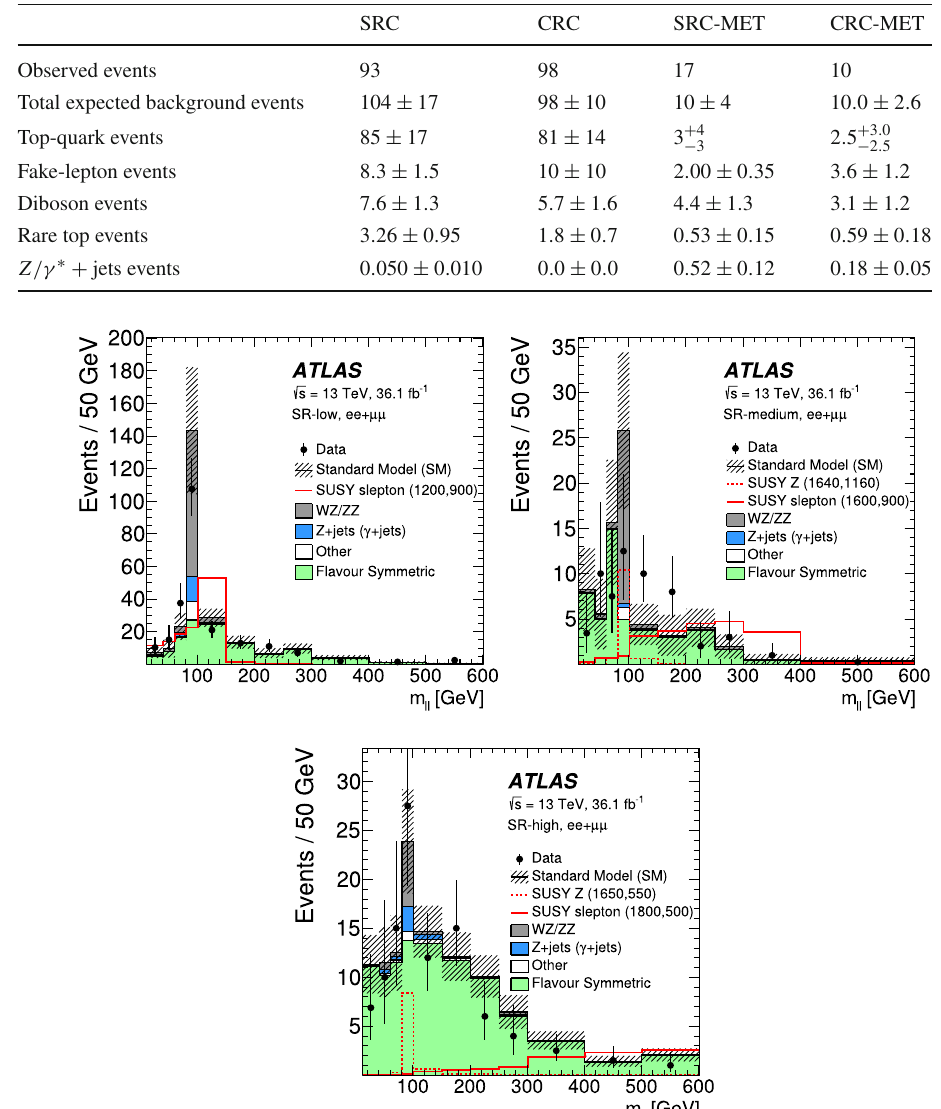
expected background and observed data yields for SR-low, SR-medium and SR-high, integrated over the m (cid:4)(cid:4) spectrum. The quoted uncertainties include statistical and systematic contributions, and due to anti-correlations with the CR, the total uncertainty may be less than the sum of individual parts